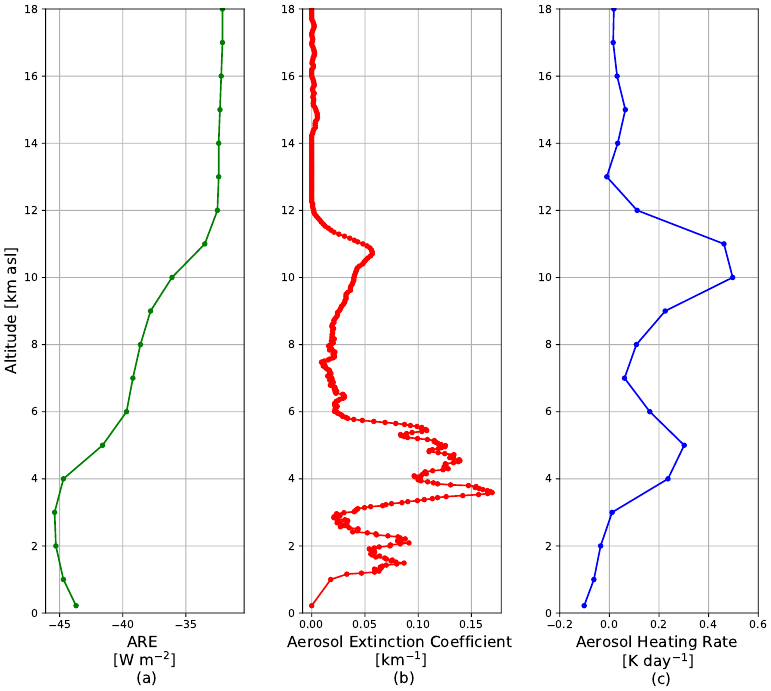
Figure 3. ( a ) Aerosol Radiative Effect (ARE) profiles for 21 August 2017 at SZA = 78 ◦ calculated by using ( b ) the aerosol extinction profile derived from CALIOP and ( c ) Aerosol Heating Rate (AHR) profiles for 21 August 2017 SZA = 78 ◦